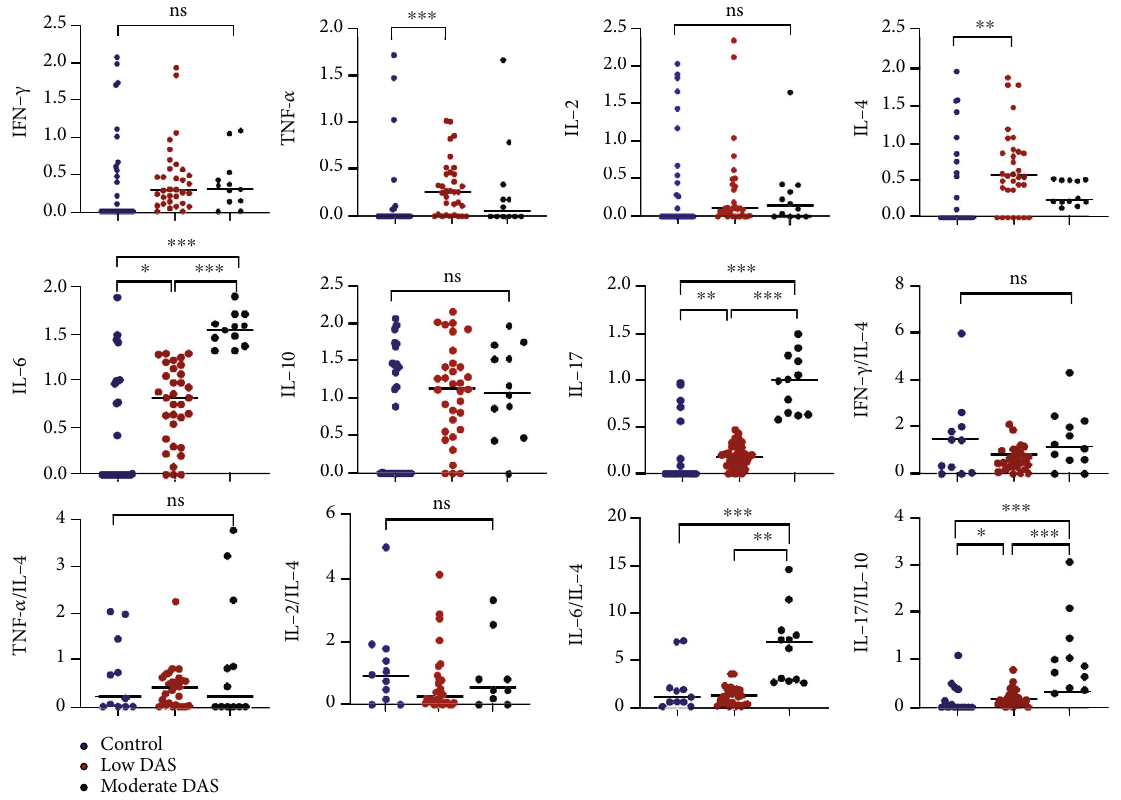
Figure 2: Comparison of T cell cytokines and their ratios between healthy controls and RA cases based on DAS28 scores. ∗ p < 0 : 05 , ∗∗ p < 0 : 01 , ∗∗∗ p < 0 : 0001